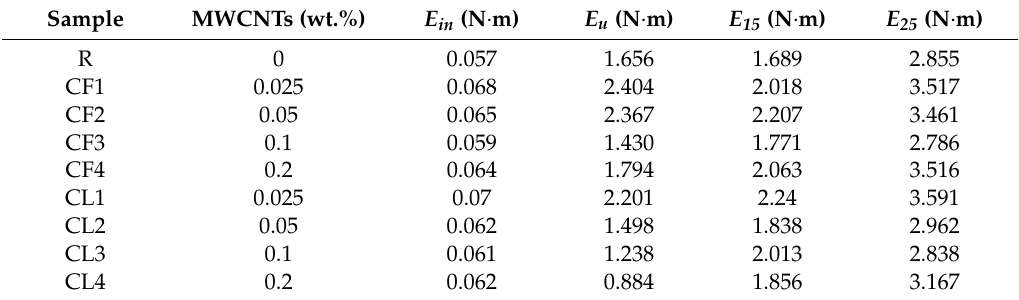
Table4. Energyabsorptioncapabilitiesofreactivepowderconcretespecimenswithvariousmulti-walled carbon nanotubes